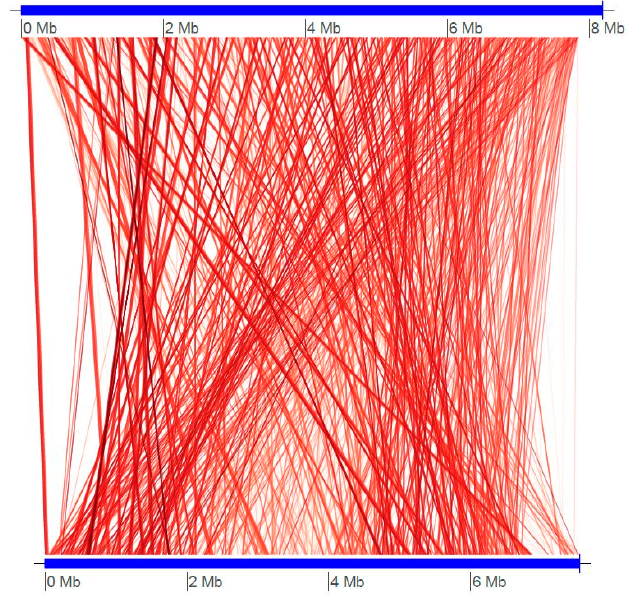
Figure 3. Genome alignment between Streptomyces isolate BR123 and Streptomyces globosus . Alignment was performed using the online KBase tool with default parameters. Synteny regions are represented by red lines, whereas breaks in synteny are the blank regions. Genome sizes are marked in the horizontal panels and conserved regions are linked.